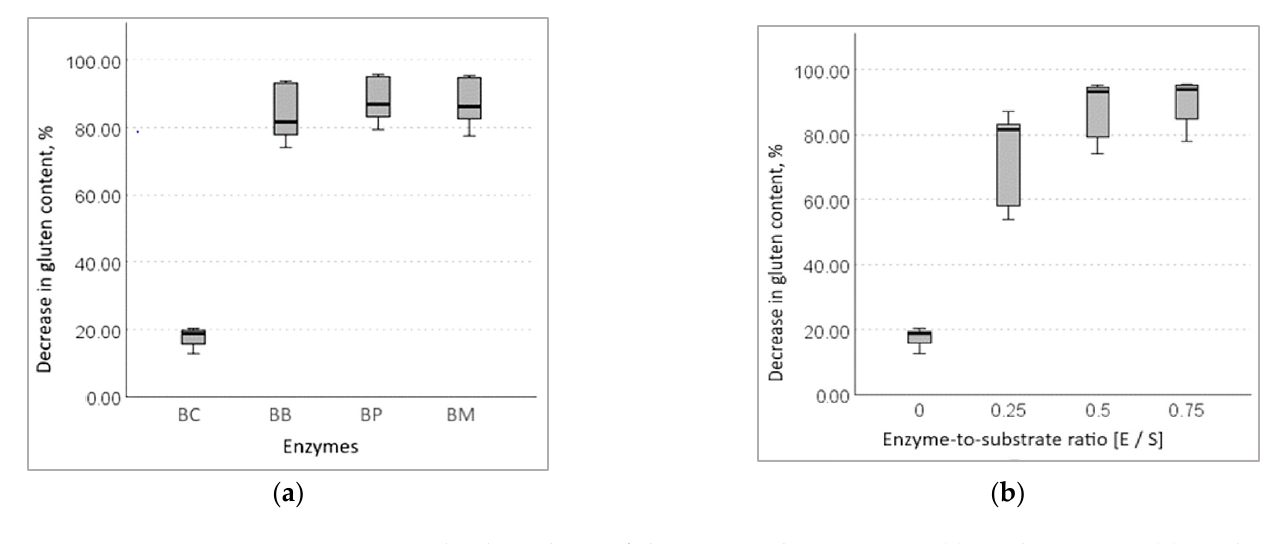
Figure 4. The dependence of decrease in gluten content: ( a ) on the enzyme; ( b ) on the enzyme/sub- strate ratio (BC, control bran sample; BB, bran treated with bromelain; BP, bran treated with papain; BM, bran treated with a combination of bromelain and papain).